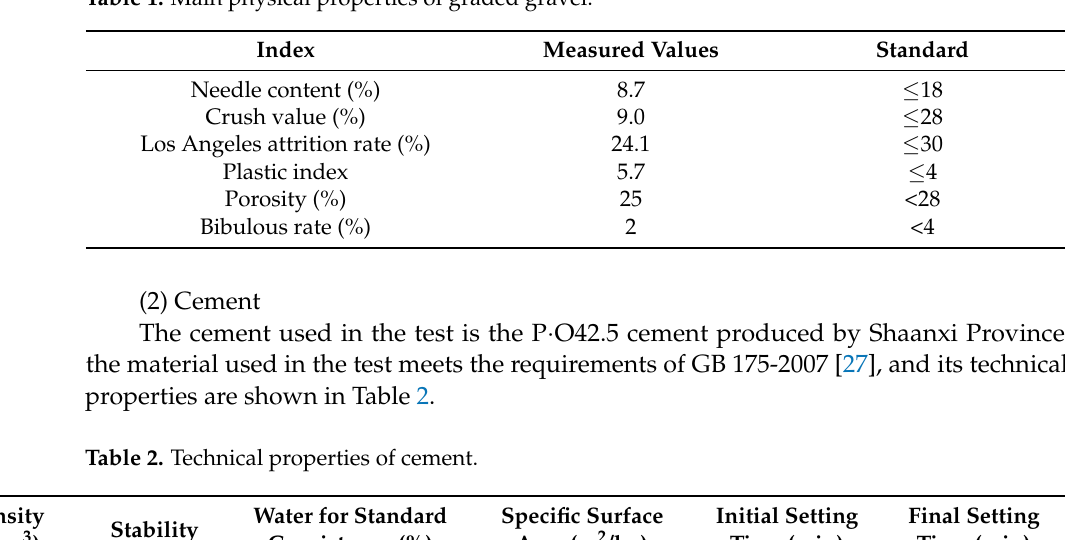
Table 1. Main physical properties of graded gravel.